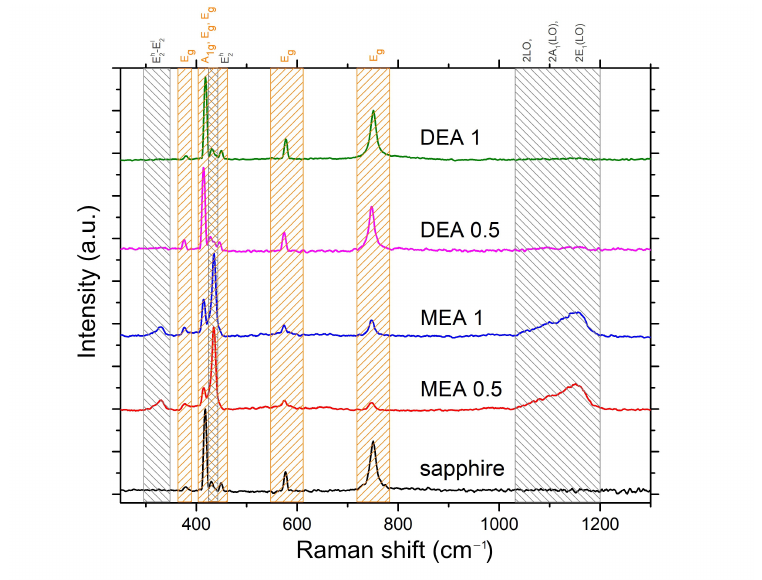
Figure 8. Raman spectra for samples grown on sapphire. The grey tags relate to the ZnO bands and orange-to the Al 2 O 3 peaks.